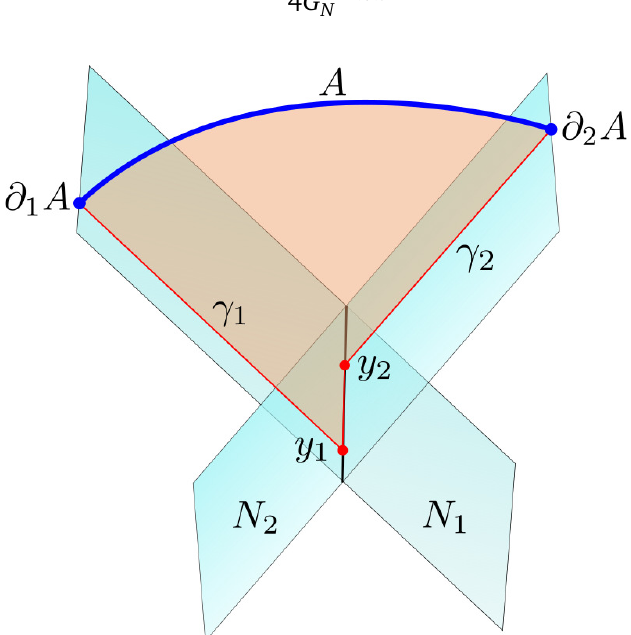
Figure 1: Extremal curve homologous to an interval in a GCF T gravity in asymptotically flat spacetime. Figure modified from [ 61 ]